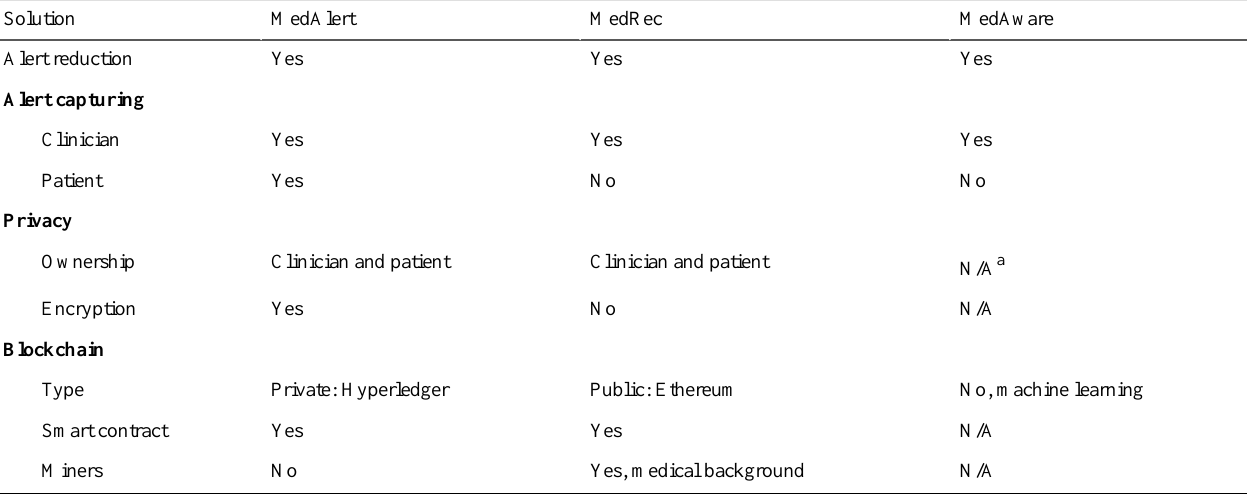
Table 1. Comparison of different framework